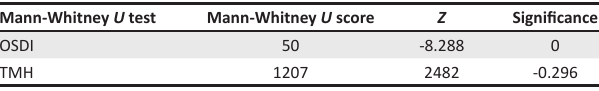
TABLE 4: Pearson’s correlation coefficients for both the keratoconic and the control groups.